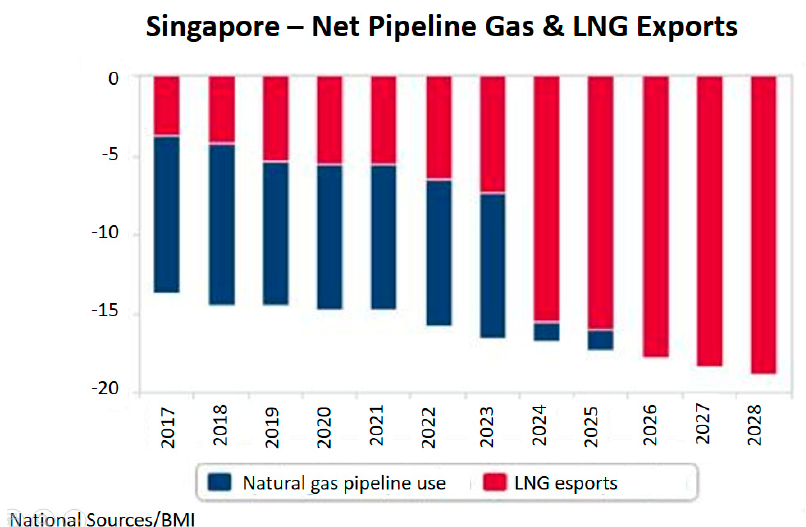
Figure 1. Expected increase in use of LNG